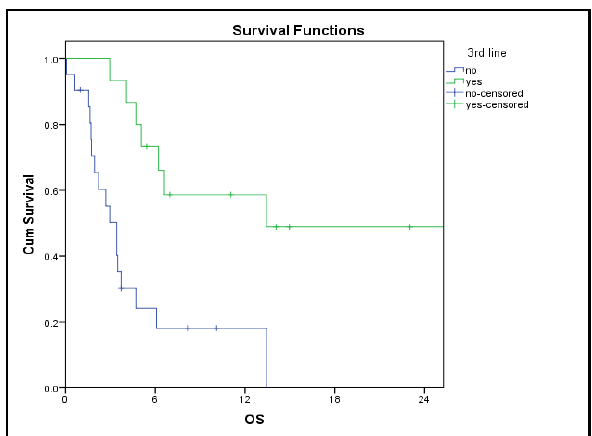
Figure 2. Overall survival curves of 3 rd line versus best supportive care